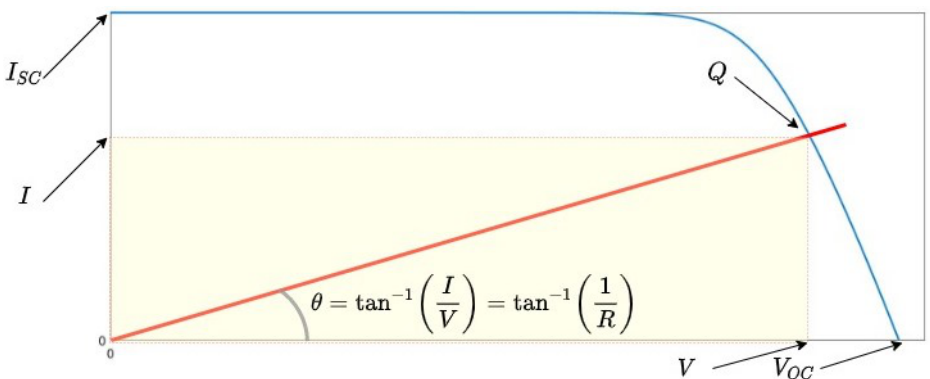
Figure 5. Example of a I(V) solar cell characteristic (blue) and a graphical solution of its operating point Q for a load resistance R